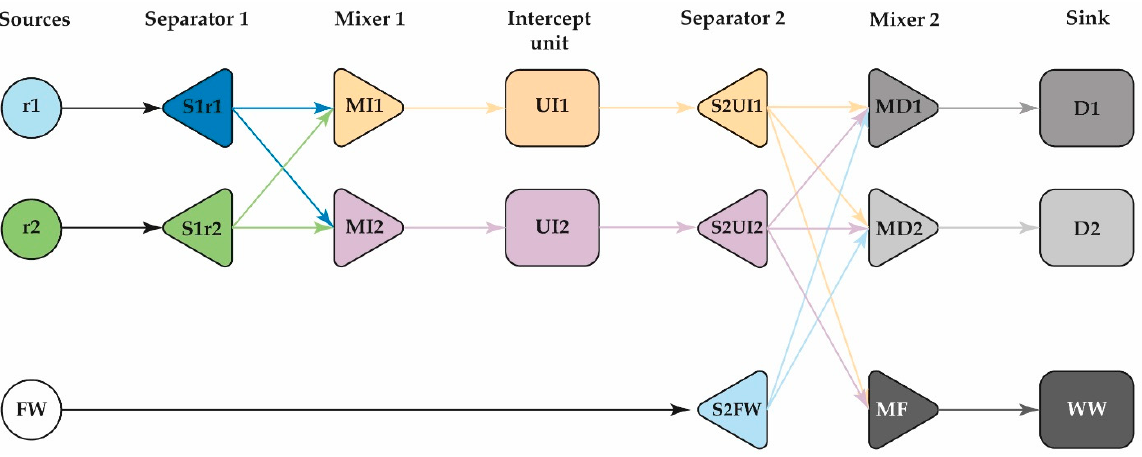
Figure 2. General superstructure design.